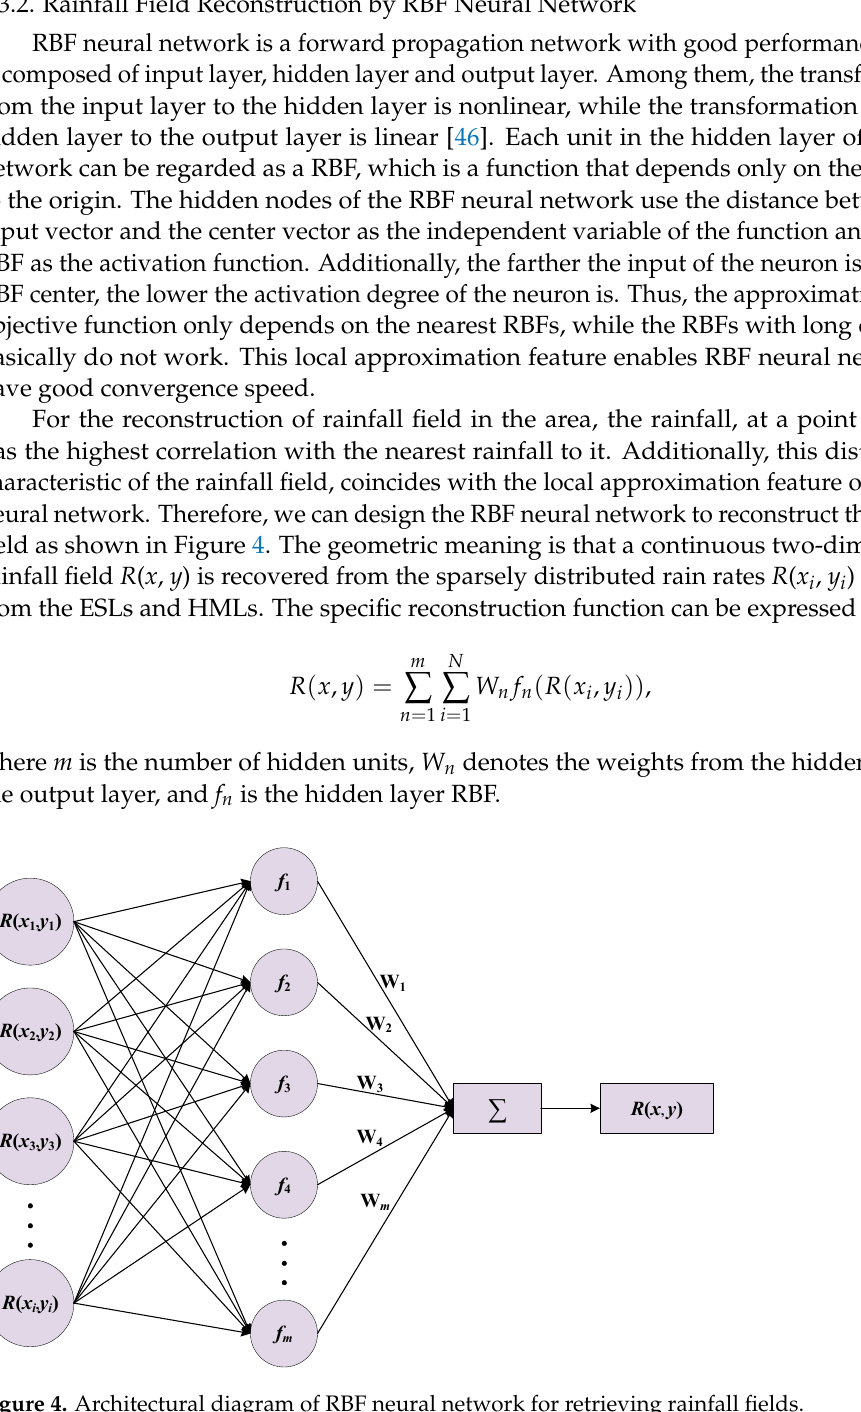
Figure 4. Architectural diagram of RBF neural network for retrieving rainfall fields.